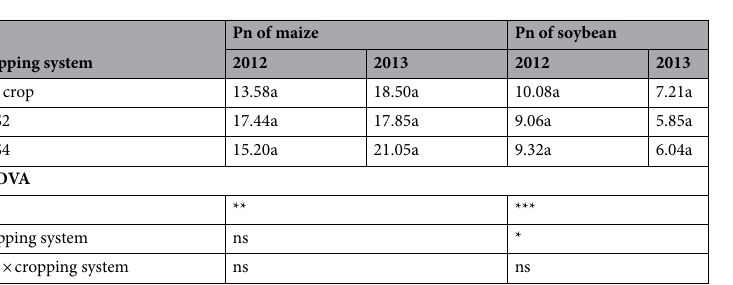
Table 1. The leaf photosynthetic rate (Pn, μmol m −2 s −1 ) of maize and soybean under sole cropping and intercropping systems in 2012 and 2013. M2S2—two rows of maize intercropped with two rows of soybean; M2S4—two rows of maize intercropped with four rows of soybean. *, significant at 0.05 level; **, significant at 0.01 level; ***, significant at 0.001 level; ns, no significant difference. For each column, mean values indicated by different letters are significantly different at the 5% level using